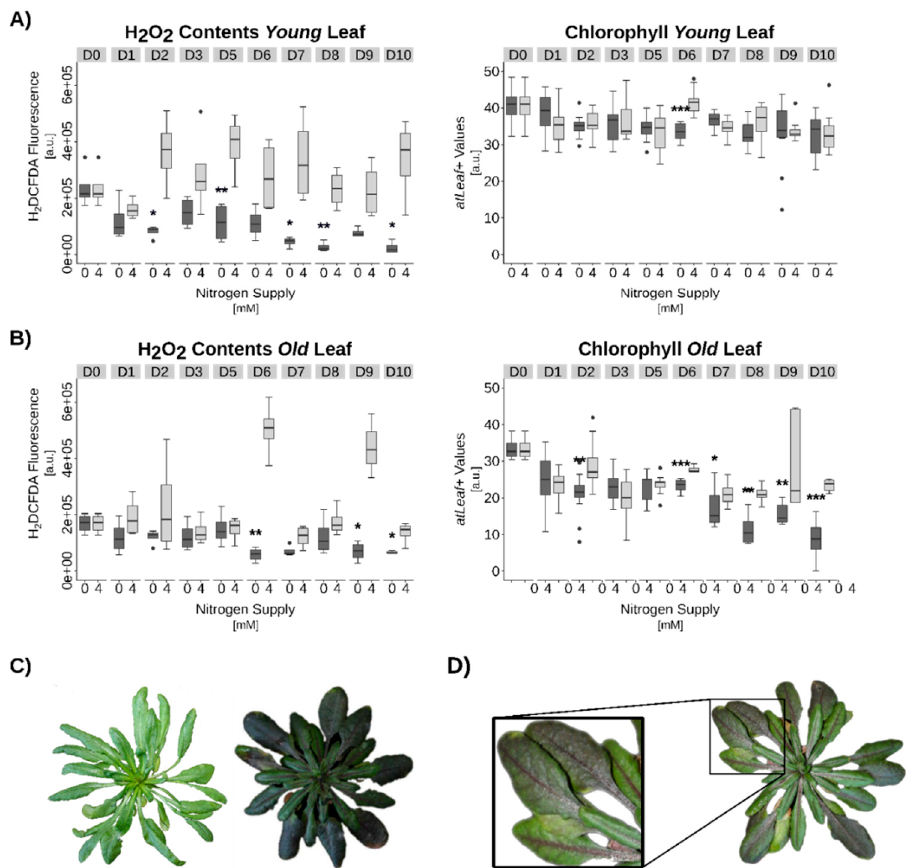
Figure 6. Nitrogen (N) starvation induced senescence in Arabidopsis thaliana . ( A ) Hydrogen peroxide (H 2 O 2 ) and chlorophyll contents in young leaves, ( B ) in old leaves. ( C ) Left: plants grown under full N-supply, right under N-starvation. ( D ) Exemplary anthocyanin accumulation pattern in N-starved plants. Statistics: Welch’s t-test. Significance levels: p < 0.001 = ***; p < 0.01=**; p < 0.05 = *. Data are medians +/ − 1.5xIQR of at least 3 biological and 2 technical replicates each.